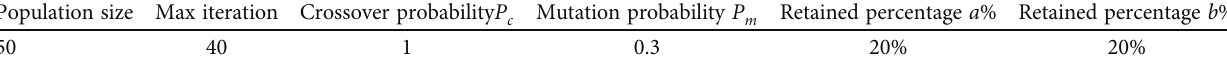
Table 4: Algorithm parameter settings.